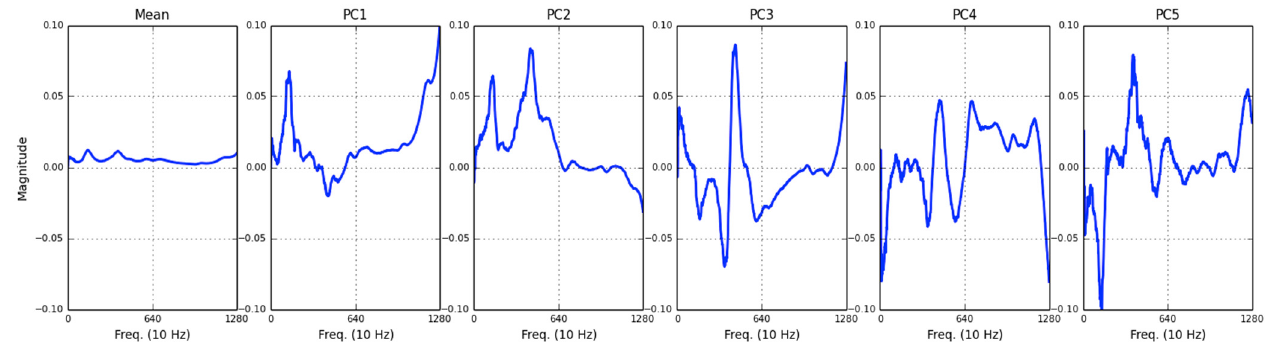
Figure 9. The mean and the first five PCs of the spectrogram of learning instance Bearing1-2. Note: the horizontal axis’ ticks represent 10 Hz per tick mark.